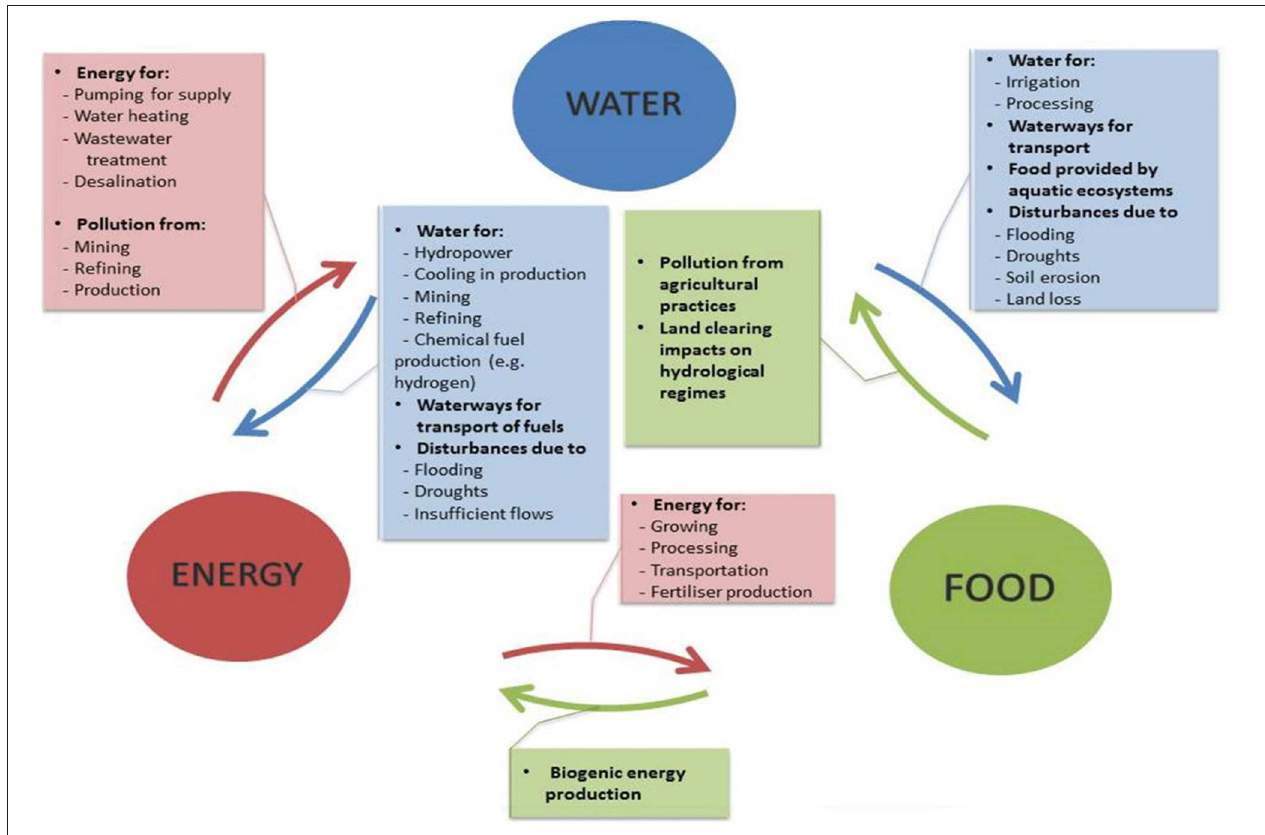
FIGURE 1 | The WEF Nexus concept. Source: IW: LEARN, Germany and GWP-Med,